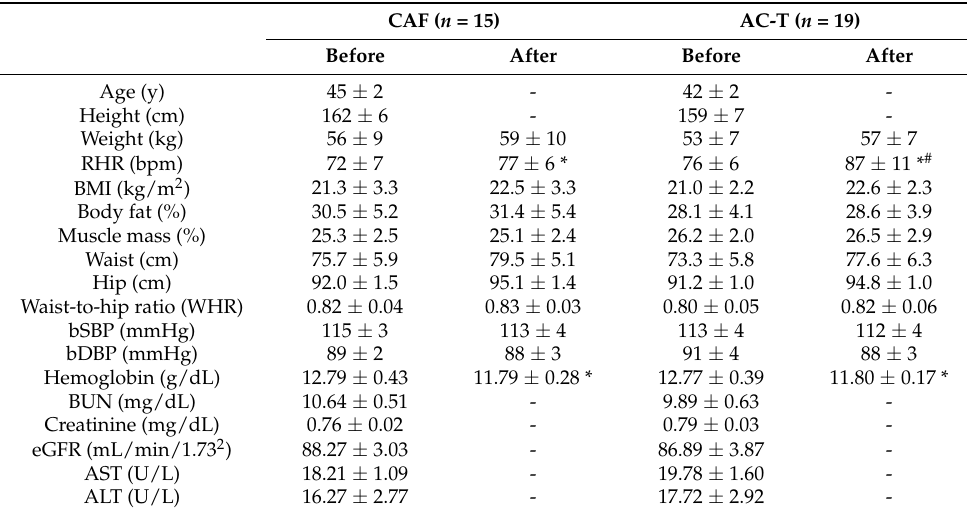
Table 1. Basic anthropometrical and blood biochemical characteristics of participants.